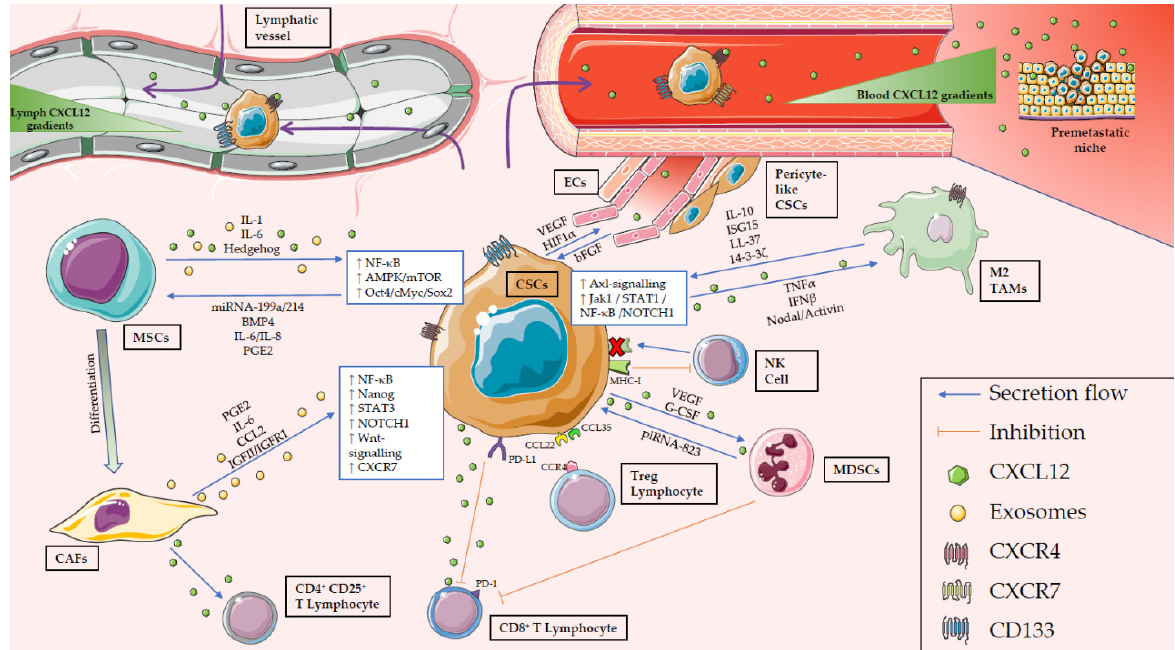
Figure 1. Schematic representation of the CSC niche and CXCL12 fluxes. CSCs are surrounded by different kinds of stromal cells which support their stemness and promote cell survival, proliferation, migration, immune evasion, and self-renewal. These processes are regulated by a myriad of cytokines, receptors, and extracellular vesicles. In particular, CXCL12 fluxes represent one of the key players in the CSC niche. CXCL12 is produced by MSCs and CAFs to induce stemness in tumor cells and recruit CD4 + CD25 + T cells, respectively. It is also secreted by CSCs not only to recruit M2 TAMs and MDSCs, but also to inhibit possible interactions with CTLs. Importantly, CXCR12/CXCR4/CXCR7 axes strongly induce CSC migration from the primary tumor through a blood CXCL12 gradient that originates in the premetastatic niche. Finally, the interaction between stroma and endothelial cells with CSCs enhances their invasive and intravasive abilities.